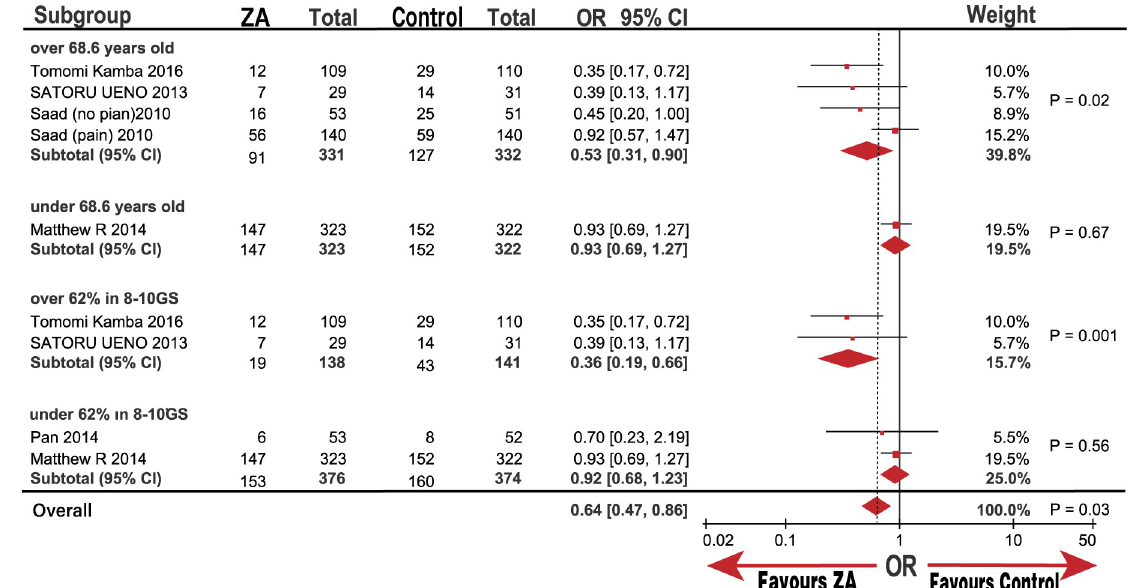
Fig 10. Forest plot odds ratio (OR) of Skeletal related events (SREs) in subgroup of age and GS.